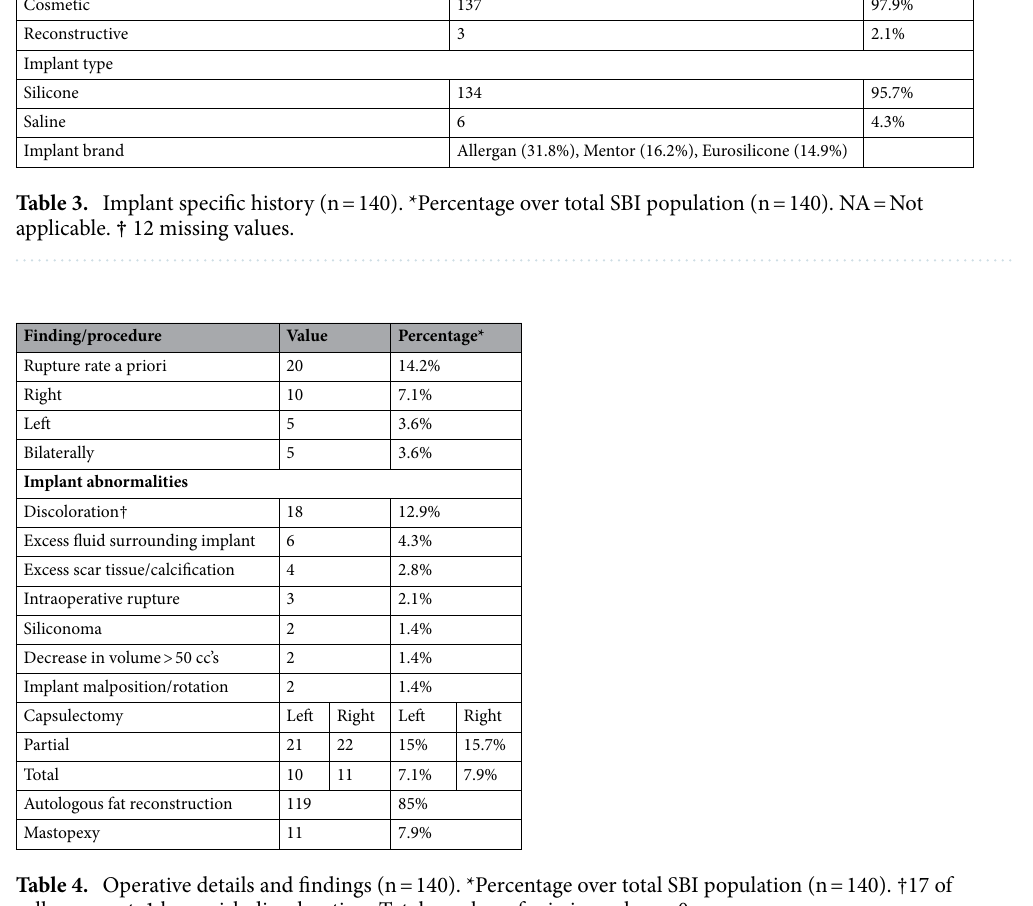
Table 4. Operative details and findings (n = 140). *Percentage over total SBI population (n = 140). †17 of yellow aspect, 1 brownish discoloration. Total number of missing values = 0.